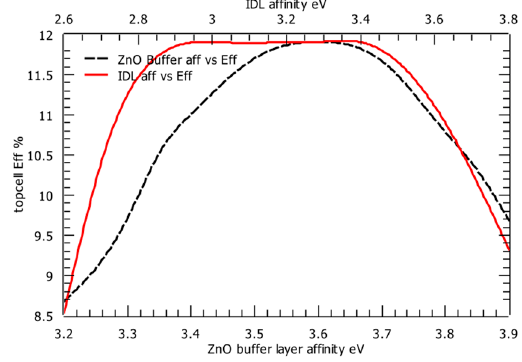
Figure 4. Buffer electron mobility (cm 2 /V ∙ s) vs. top subcell fill factor and efficiency.